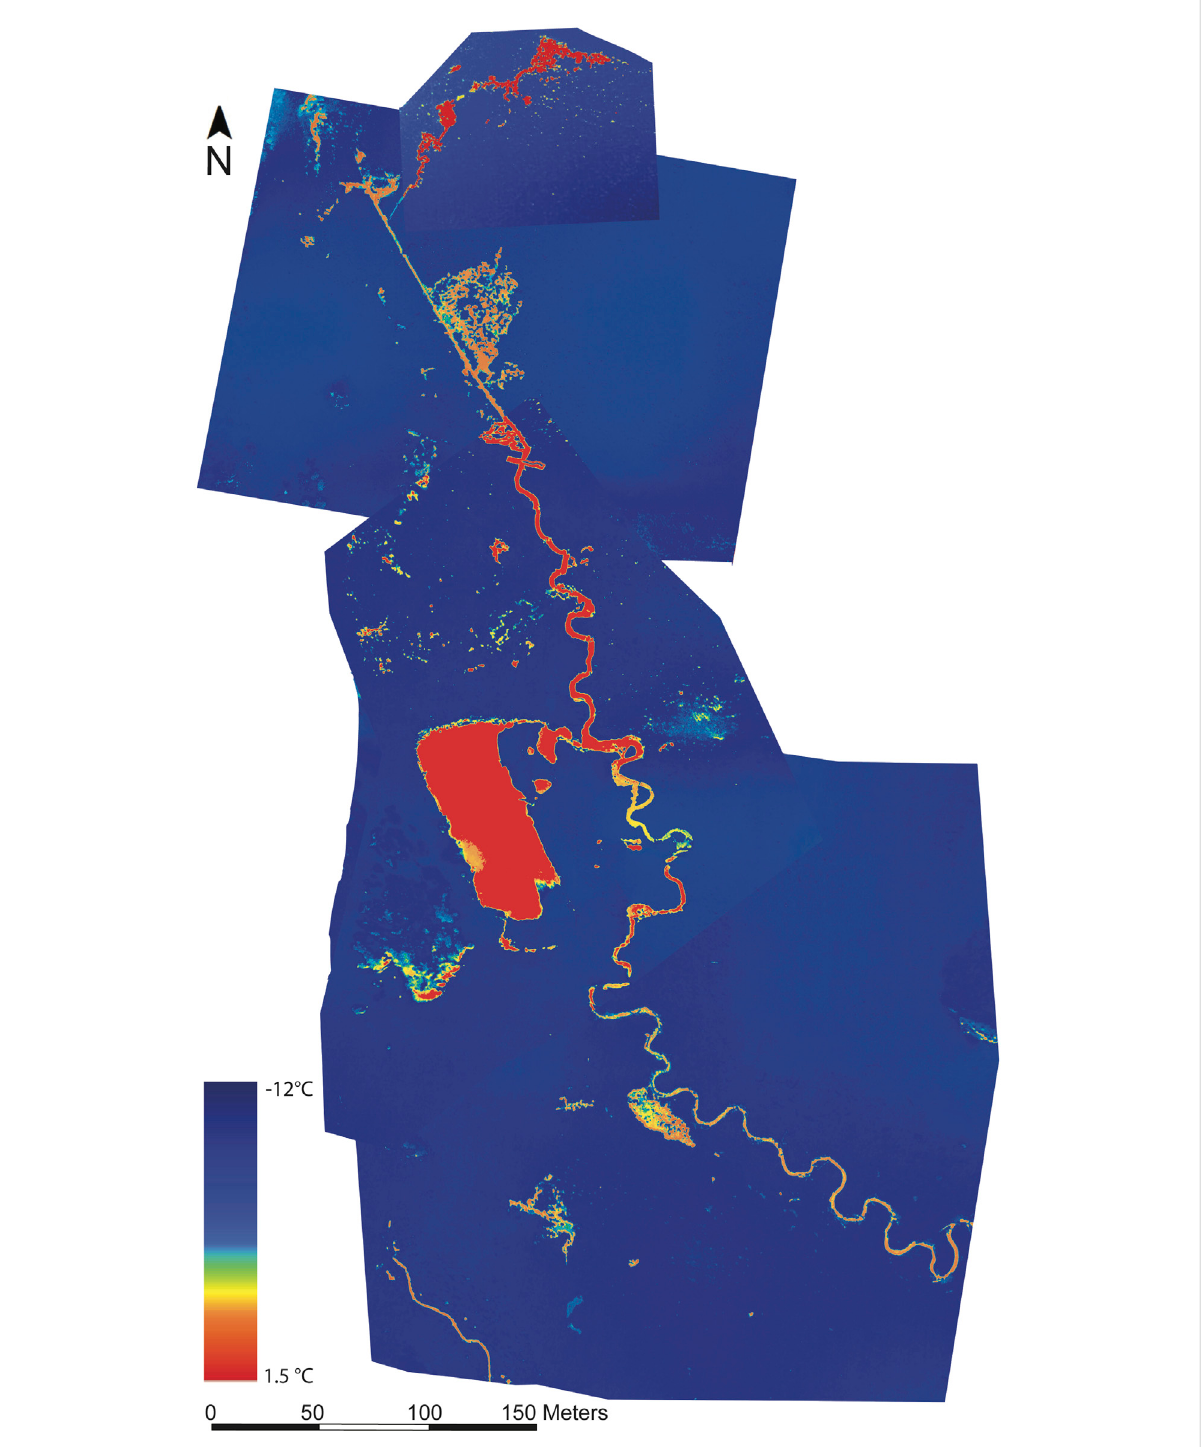
FIGURE 4 Orthomosaic image of post-restoration UAS-derived thermal infrared imagery 14 February 2021. Ground surface is cold (blue). Much of the surface has been altered with microtopography, allowing more free expression of warmer groundwater (red and orange) areas, which fl ow into the reconstructed meandering